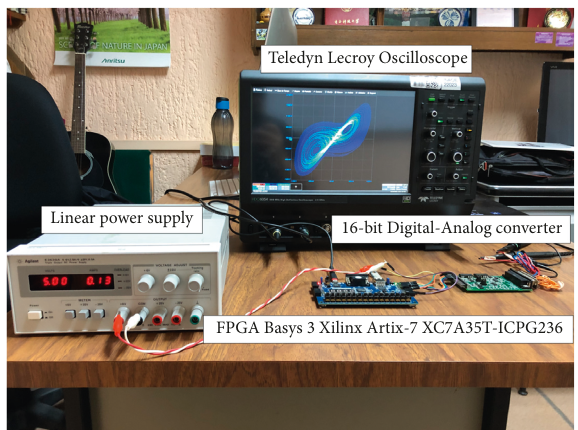
Figure 35: Experimental setup to measure the attractors of the proposed model (1) using a FPGA basys 3 xilinx artix-7 XC7A35T- ICPG236, a 16 bit digital-analog converter, a linear power supply and a keysight oscilloscope to visualize the hyperchaotic